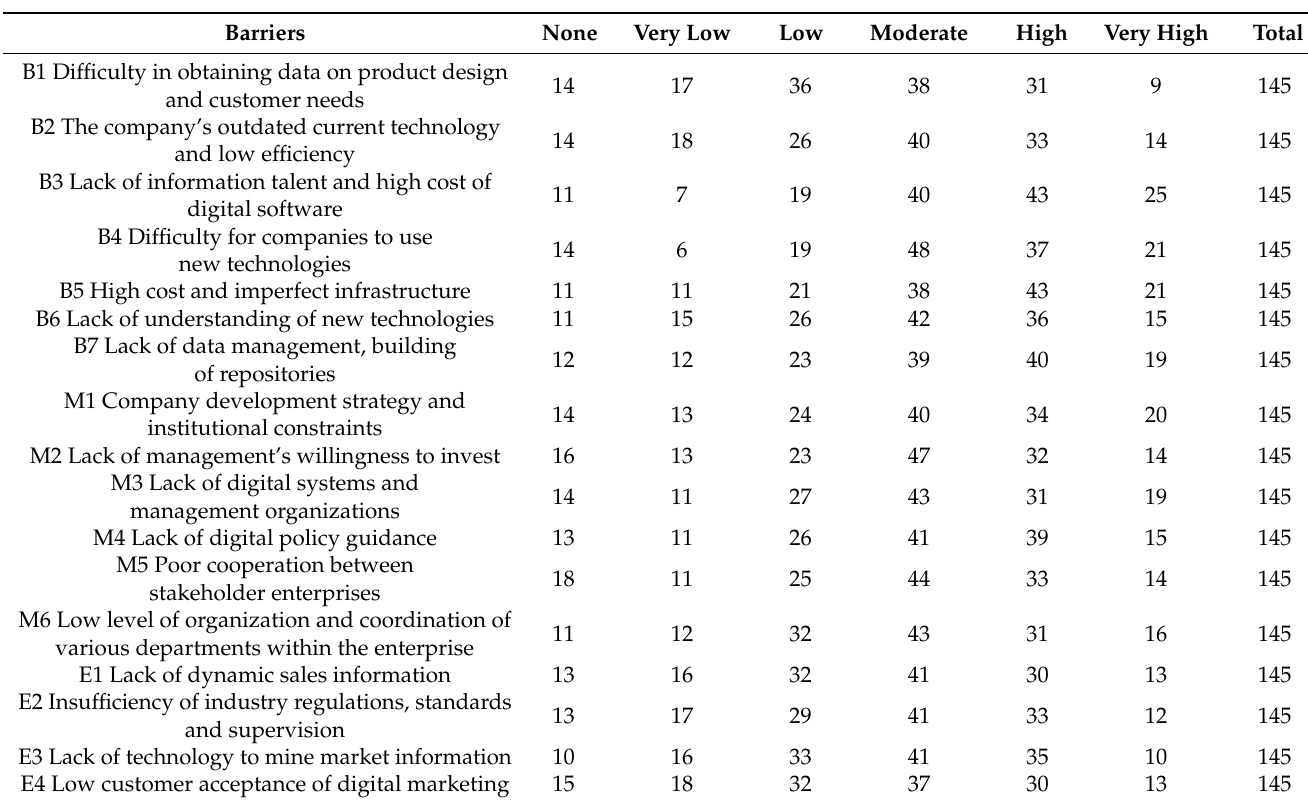
Table 4. Disability score counting table.